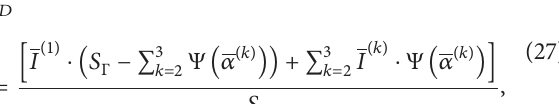
Figure 23: The sketch of the double-bottom structure cell subjected to underwater